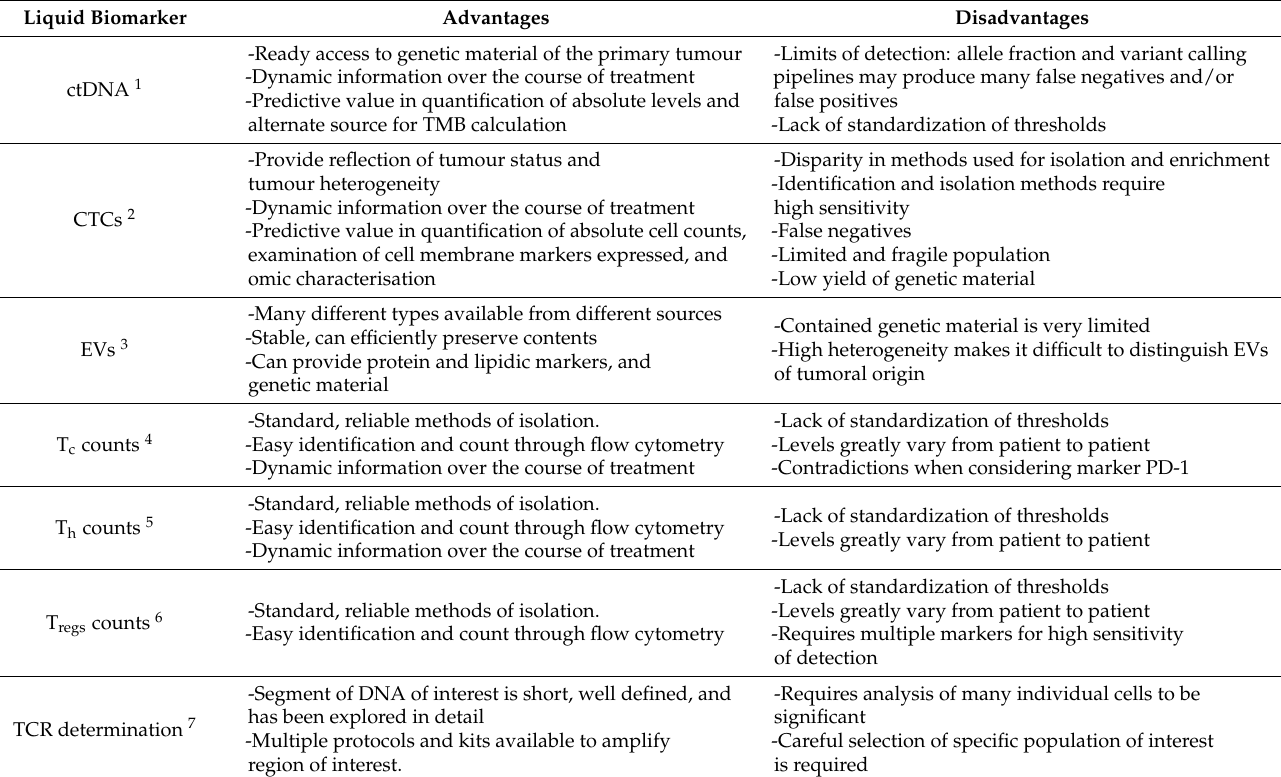
Table 2. Advantages and disadvantages of the liquid biomarkers with potential use in immunotherapy response monitoring. Liquid Biomarker Advantages